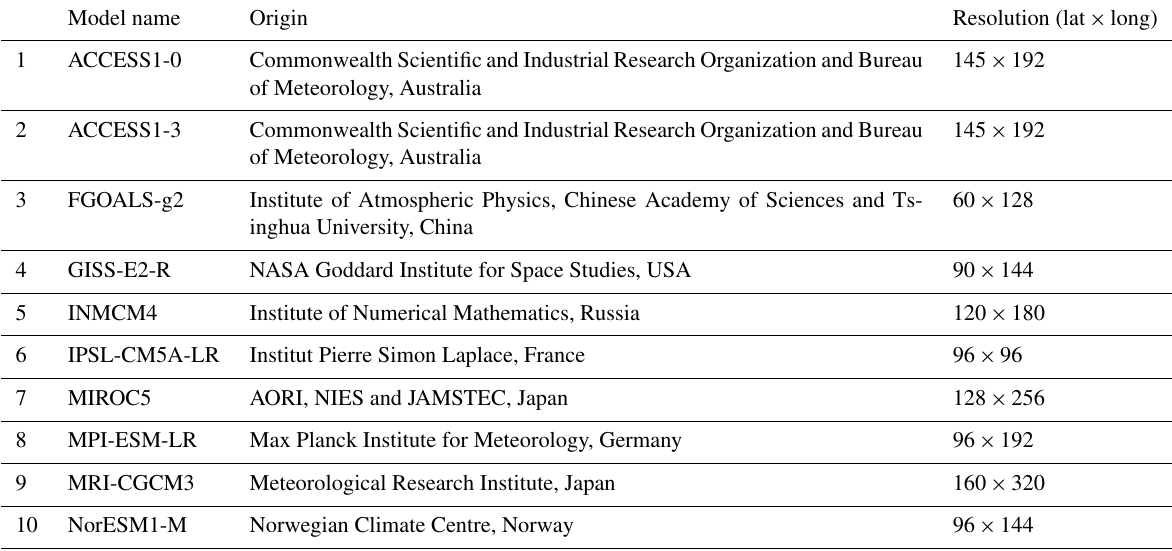
Table 1. The list of CMIP5 models used in the study and their atmospheric horizontal